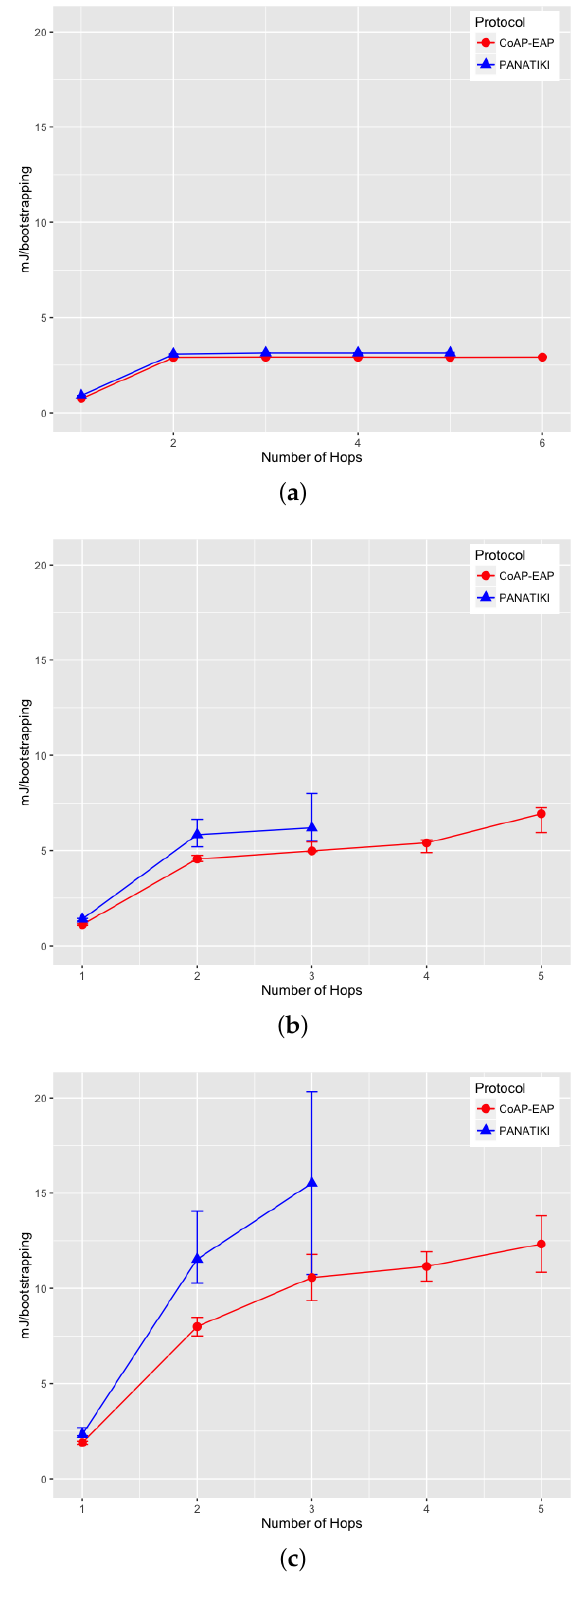
Figure 13. TX energy consumption. ( a ) TX energy consumption with 0.0 loss ratio; ( b ) TX energy consumption with 0.1 loss ratio; ( c ) TX energy consumption with 0.2 loss